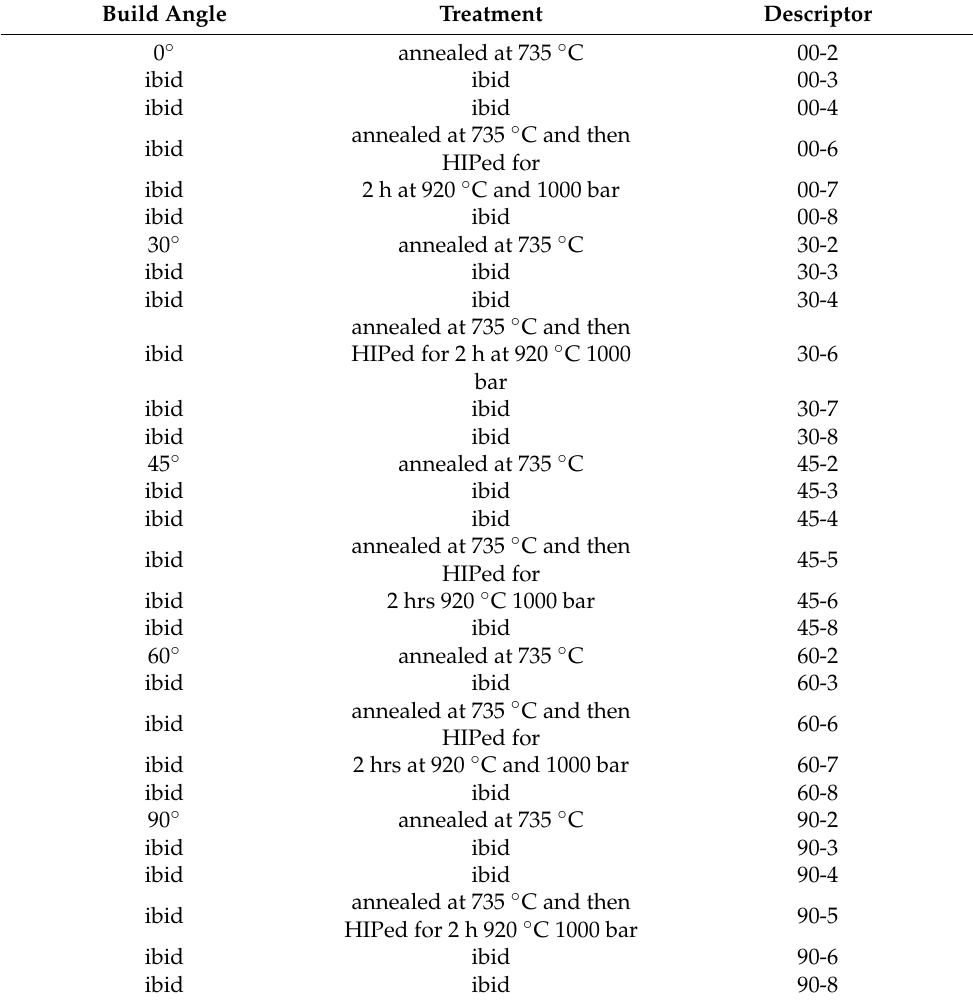
Table 1. Notation associated with the specimen tests reported in